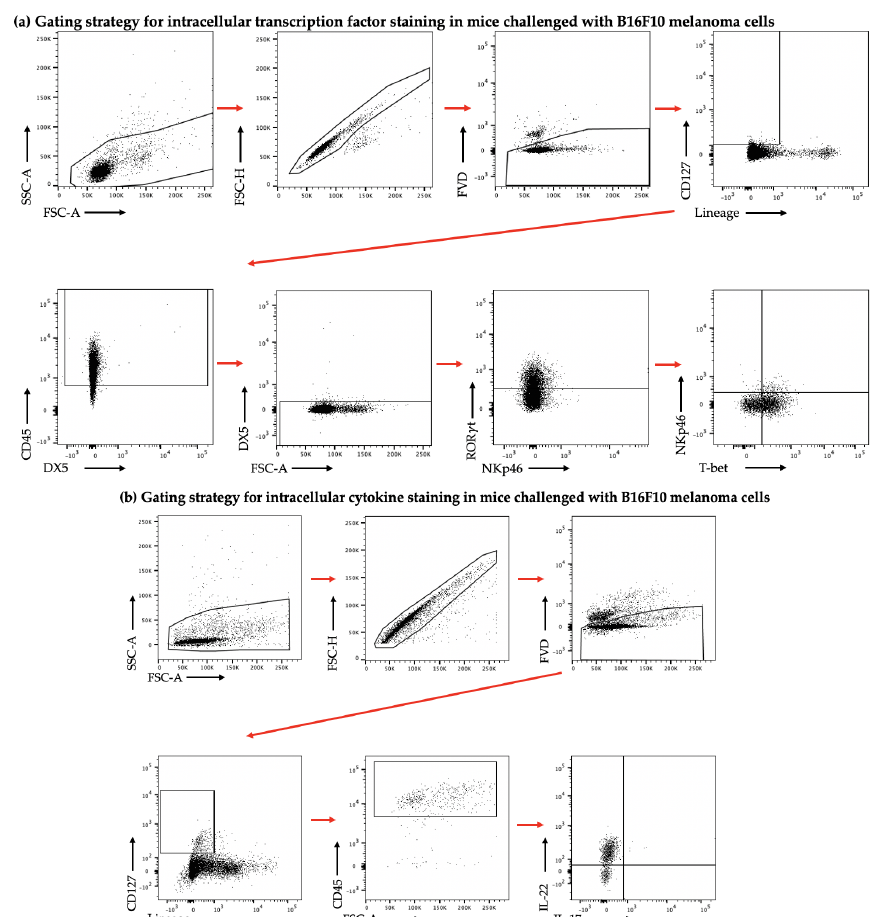
Figure A2. Representative dot plots of the flow cytometry gating strategy used for mice challenged with B16F10 melanoma cells. The populations were examined through flow cytometry for ( a ) tran- scription factor staining analyzed in Figures 4 and 6 and for ( b ) intracellular cytokine staining analyzed in Figures 5 and 7.